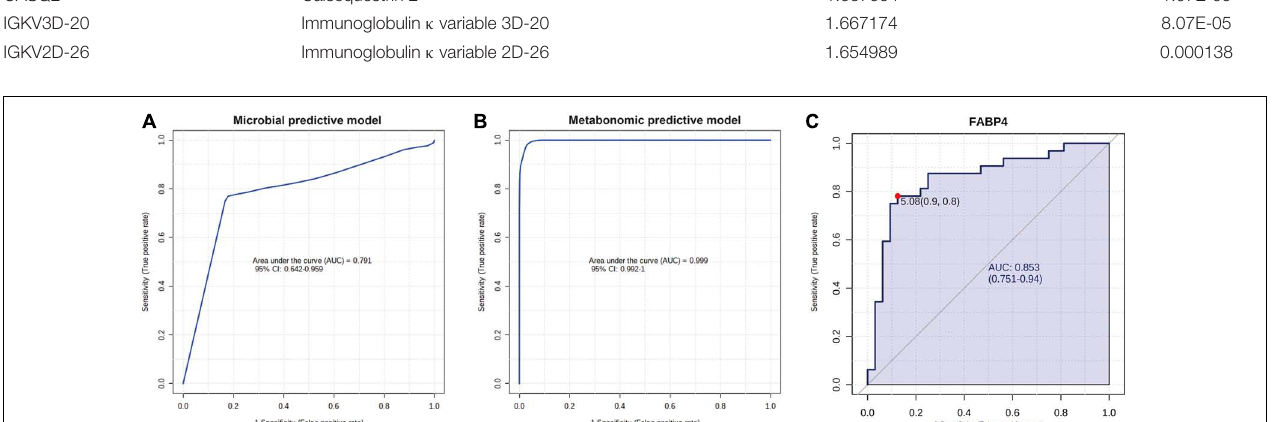
FIGURE 8 | Potential diagnostic value of differential gut microbiota, metabolites, and DEG with importance. (A) Microbial predictive model. Gut microbiota significantly enriched in CAS group were included, and RF algorithm was used to construct this model. (B) Metabolomic predictive model. Phenylacetylglutamine, phenylacetylglycine, ethanolamine, and eicosapentaenoic acid were included, and RF algorithm was used to construct this model. (C) FABP4 is the DEG with the highest log 2 (fold-change), and potential diagnostic value of this gene was shown by ROC analysis.